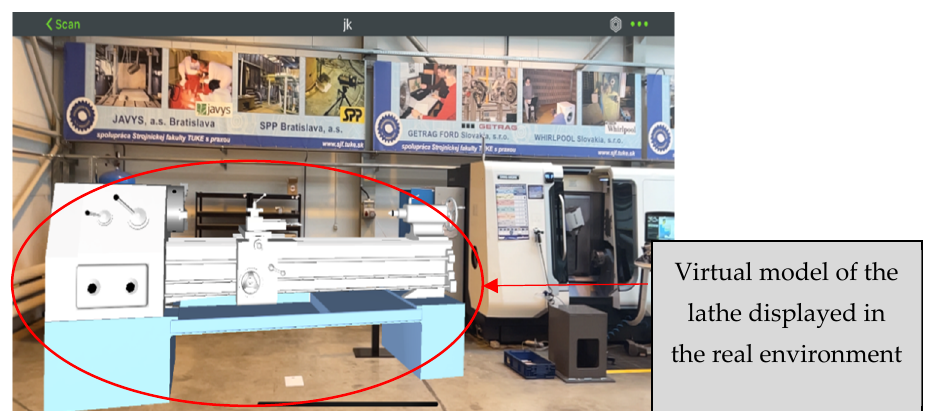
Figure 14. Display of the digital model of the lathe in the real environment.